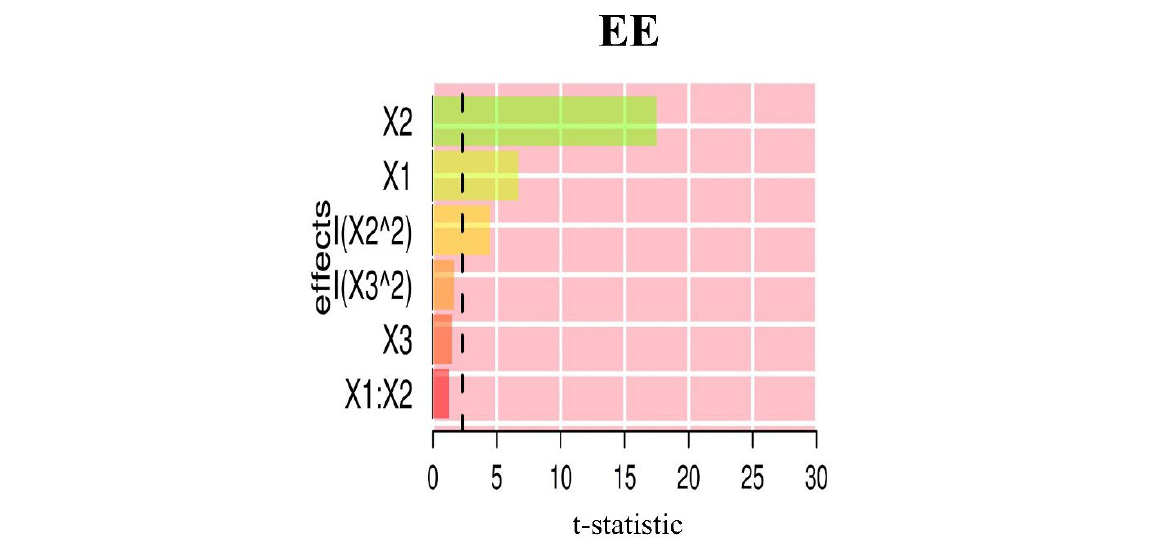
Figure 3. Pareto charts depicting the standardized impacts of independent variables: GMO concen- tration (X 1 ), P 407 concentration (X 2 ) and T 80 concentration (X 3 ).